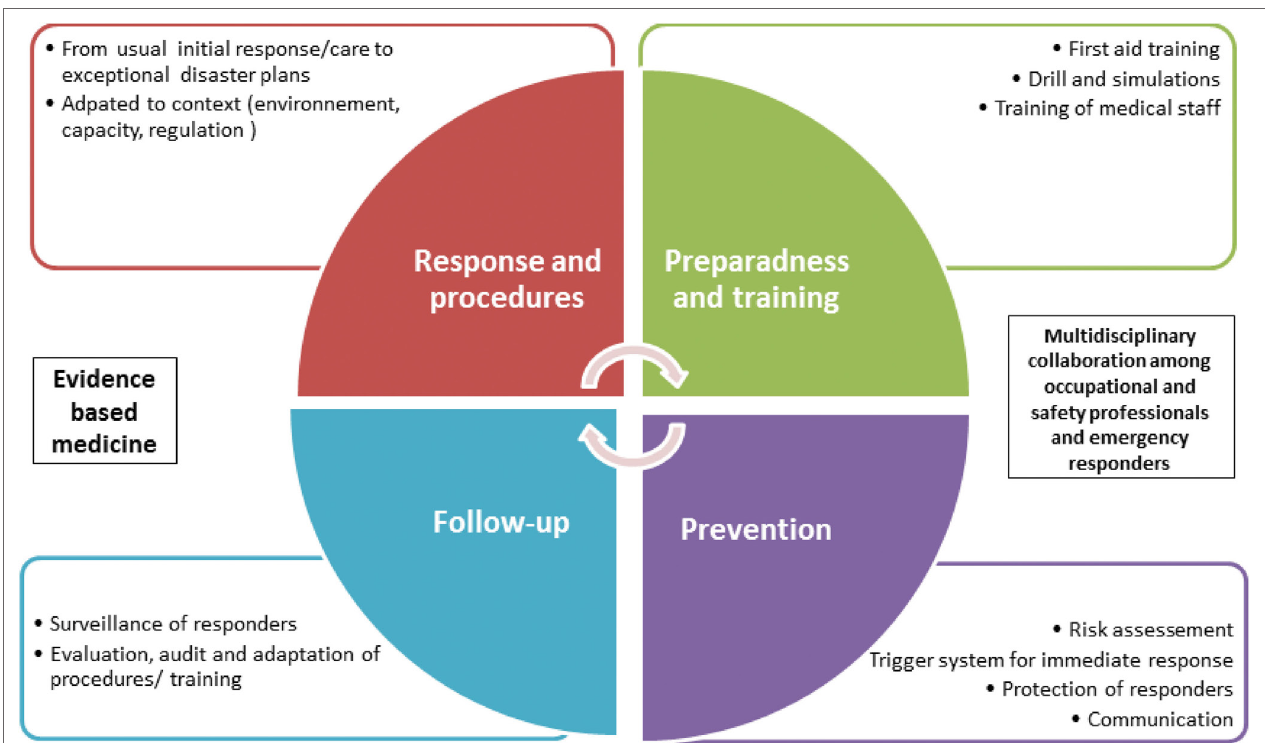
FiGURE 1 | Scope of the